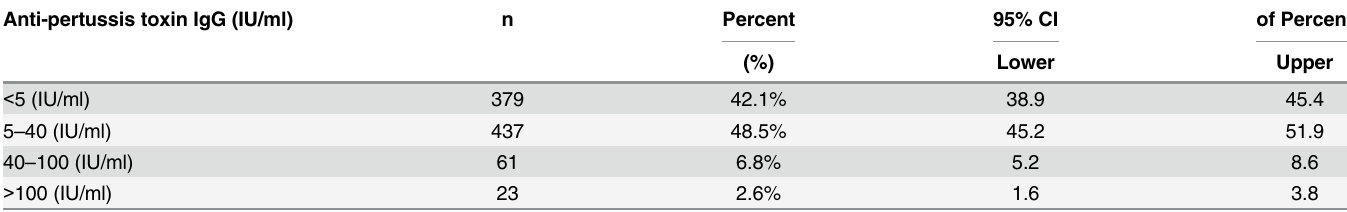
Table 2. Anti-pertussis toxin IgG level in the Thai